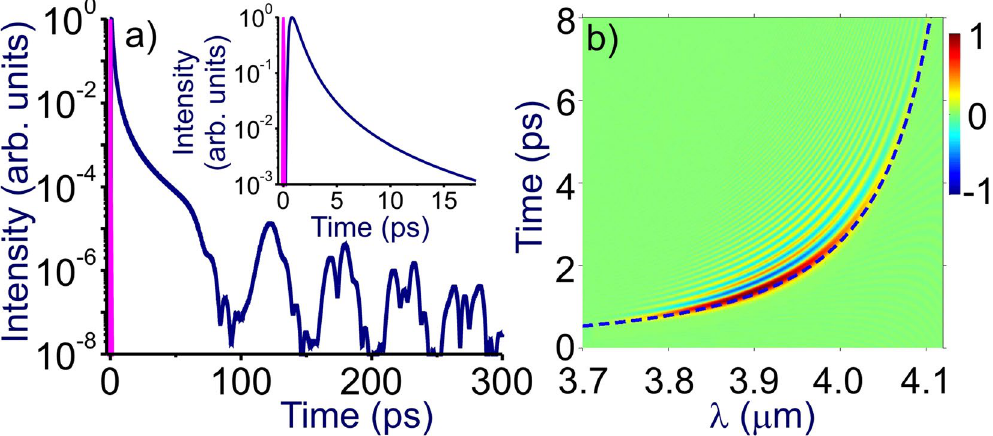
Figure 4. Temporal envelope ( a ) and the Wigner spectrogram ( b ) of an 80-fs, 3.9- μ m transform-limited laser probe with r 0 ≈ 0.7 cm transmitted through 500 m of atmospheric air calculated with Eqs (3) and (4). The input laser probe is shown by the red line. The group delay Δ τ g is shown by the dashed line in the Wigner